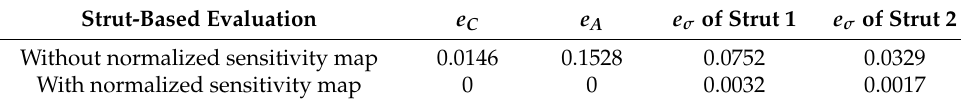
Figure 9. 3D conductivity distribution reconstructions of ( a ) 3 × 3 × 3 and ( b ) 4 × 4 × 1 (with diagonal struts) lattice structures successfully identified the broken strut in each structure.